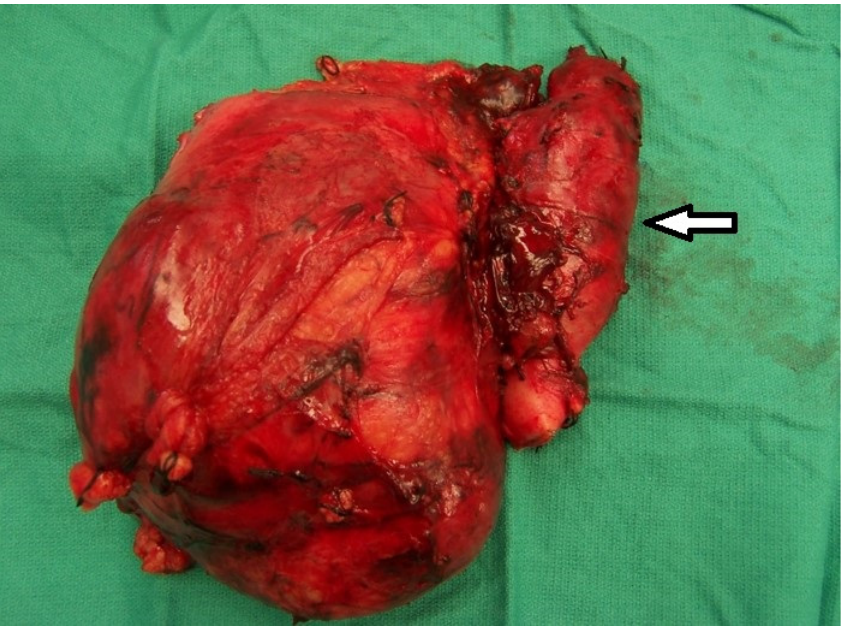
Figure 1. En-bloc resection of large right renal cell carcinoma with inferior vena cava containing tumor thrombus inside (white arrow).